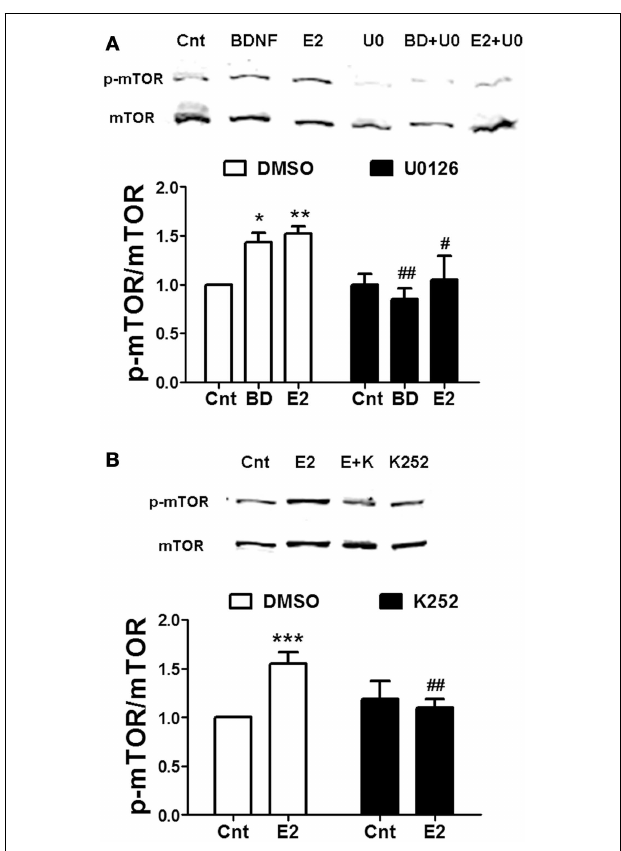
FIGURE 3 | Estradiol-induced mTOR phosphorylation involves ERK and TrkB receptor activation . Acute hippocampal slices were pre-treated with DMSO (Cnt), U0126 (U0, 5 µ M), or K252 (K, 1 µ M) for 30min and then incubated with estradiol (E2, 10nM) or BDNF (BD, 100ng/ml) for additional 30min. At the end of treatments, samples were homogenized and processed for western blot. Data are presented as the ratio (fold of control) of: (A) p-mTOR over total mTOR ( N = 3–9), (B) p-mTOR over total mTOR ( N = 8–14); * p < 0.05, ** p < 0.01, *** p < 0.001, as compared to control (DMSO); # p < 0.05, ## p < 0.01, as compared to E2 or BDNF alone (two-way ANOVA).